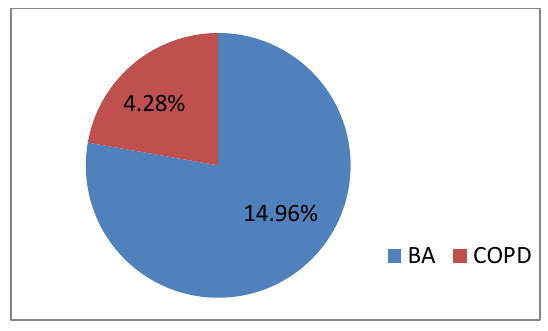
Figure 2 . Prevalence of iatrogenic Cushing's syndrome in COPD and Asthma BA= Asthma COPD=Chronic obstructive airway